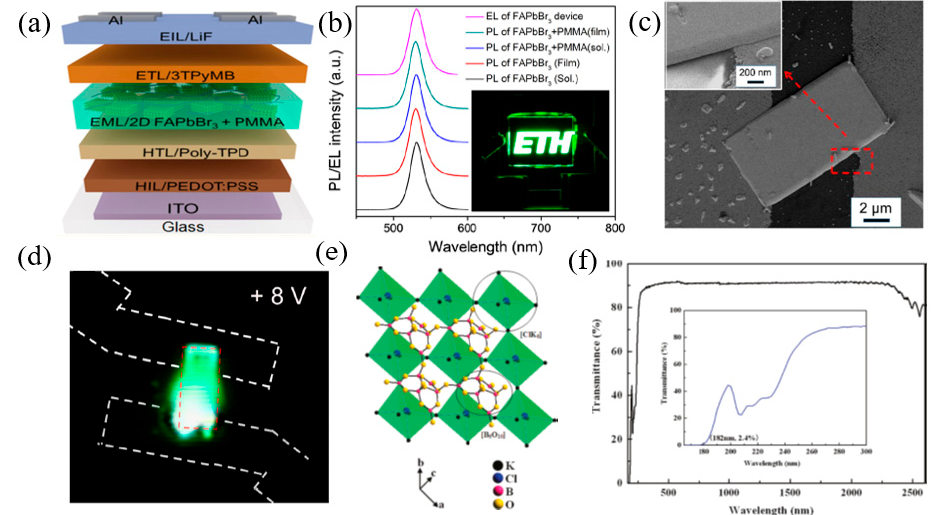
Figure 15. ( a ) Schematic architecture of vertical electroluminescent device. ( b ) PL spectrum of colloidal 2D FAPbBr 3 perovskite [284]. Copyright 2017 American Chemical Society. ( c ) SEM images of EL device showed that CsPbBr 3 nanometer plates grown in gas phase were bribed on two ITO electrodes. Azo tilt image of nanometer plate (upper left image). ( d ) Under the condition of positive bias voltage V = +8 V, EL spectrogram of CsPbBr 3 nanometer plate EL device of the upper electrode was obtained [285]. Copyright 2017 World Scientific Publishing Co. Pte Ltd. ( e ) The 3D diagram of KBOC with KO bonds. ( f ) KBOC crystal spectrum achieved from UV–vis–IR transmittance. The inset exhibits the transmittance versus λ curve between 165 and 300 nm [286]. Copyright 2011 American Chemical Society.